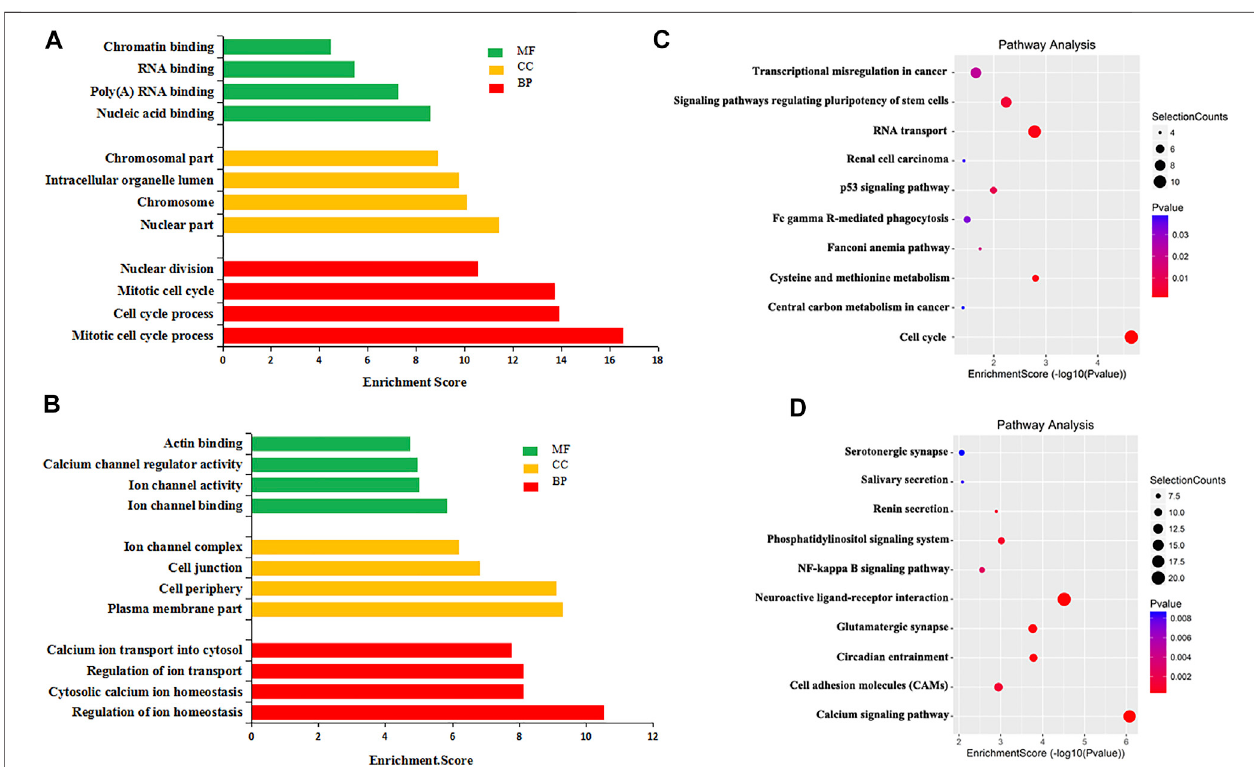
FIGURE2| GOanalysisandKEGGpathwayanalysisofdifferentiallymethylatedmRNA. (A) Thetop10GOtermssigni fi cantlyenrichedforhypermethylatedgenes. (B) Thetop 10GOtermssigni fi cantlyenriched forhypomethylated genes. (C) Thetop 10KEGGpathways signi fi cantlyenriched forhypermethylated genes. (D) The top 10 KEGG pathways signi fi cantly enriched for hypomethylated genes.